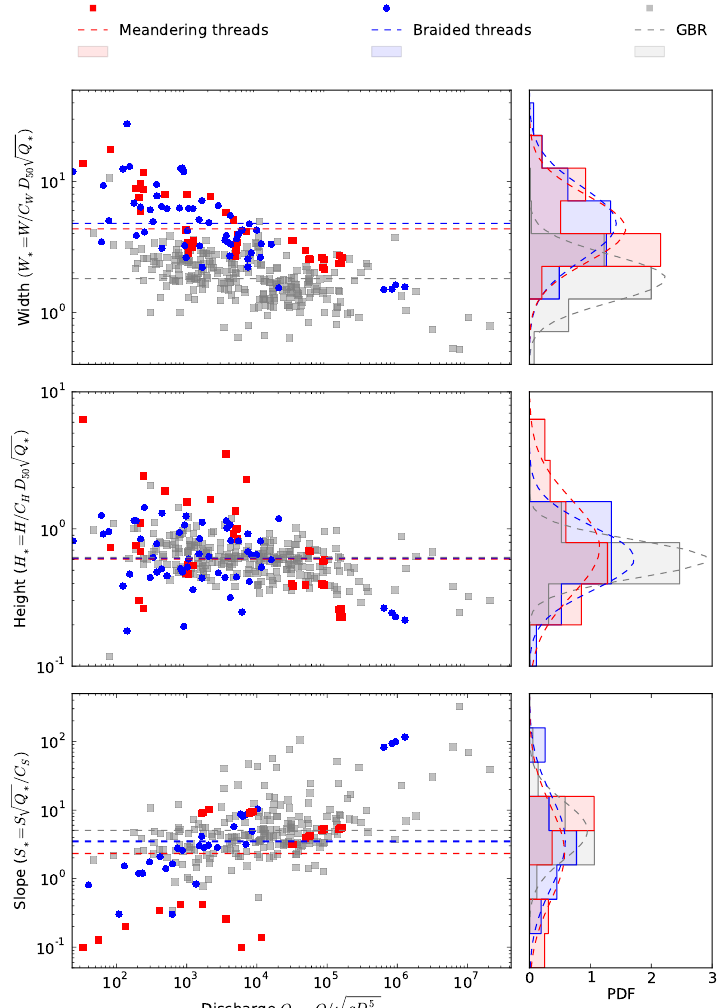
Figure 8. Left panels: rescaled width ( W ∗ ), depth ( H ∗ ) and slope ( S ∗ ) as a function of rescaled water discharge ( Q ∗ ). Rescaled quantities are from Eqs. (6) to (8). Threshold rivers correspond to rescaled width, depth and slope equal to 1. Right panels: probability density function of rescaled quantities, with fitted lognormal